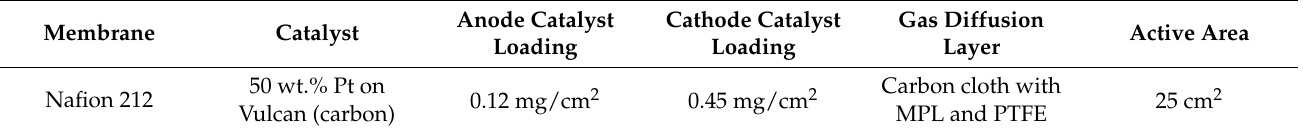
Table 4. MEA specification for single-cell